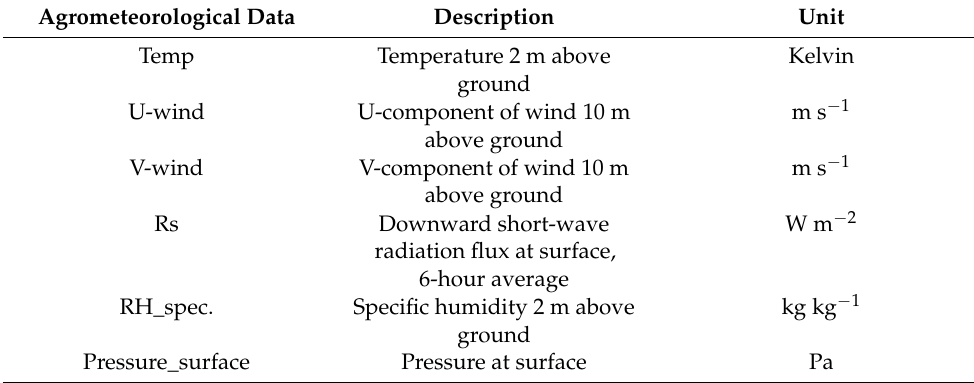
Table 1. Agrometeorological data from CFSV2, used for estimating the potential evapotranspiration (PET) (a product of the reference evapotranspiration (ETref) and the basal crop coefficient (Kcb)) computed using the standardized ASCE-Penman–Monteith